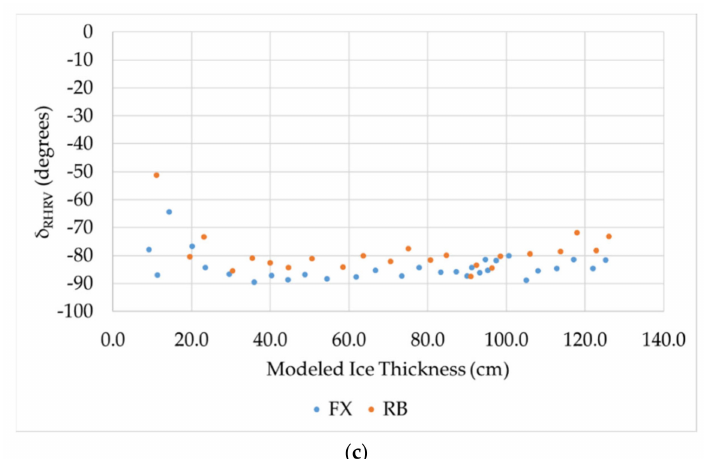
Figure 10. Temporal evolution of ( a ) σ 0 is included for values in the range sensitive to ice thickness. R is the correlation coe ffi cient of linearly regressed